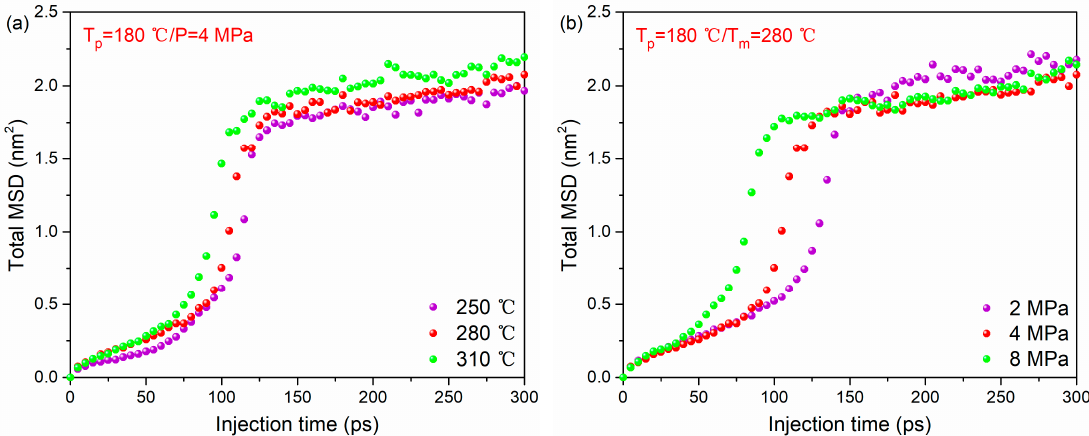
Figure 6. The MSD–time curve of PA66–PP hybrid system under various processing parameters: ( a ) melting temperatures and ( b ) injection pressure.